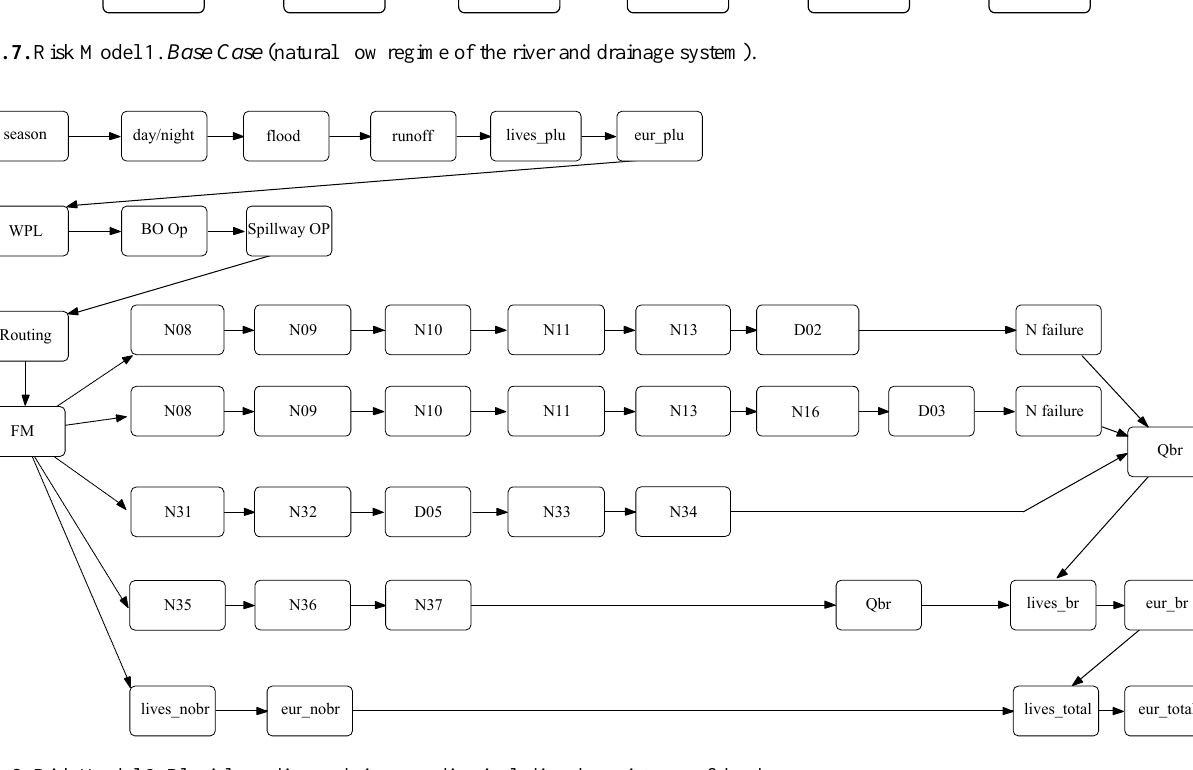
Fig. 8. Risk Model 2. Pluvial flooding and river flooding including the existence of the dam.